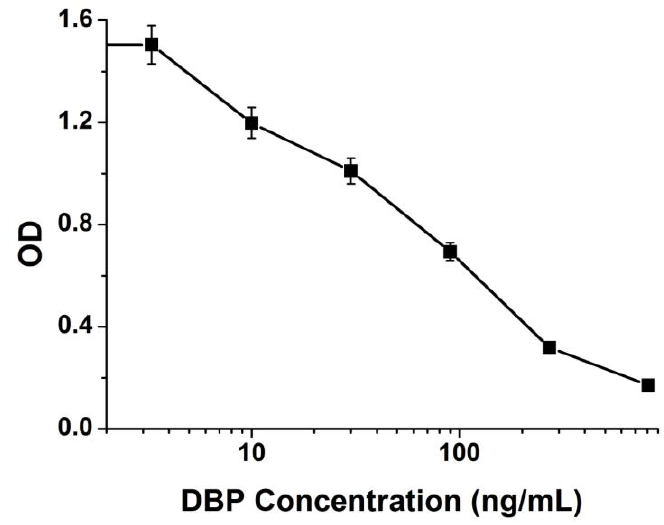
Figure 2 . Standard inhibition curve for ELISA analysis of DBP. Each point of inhibition curve represents eight replicates in analysis. The IC linear range was 5–250 ng/mL.